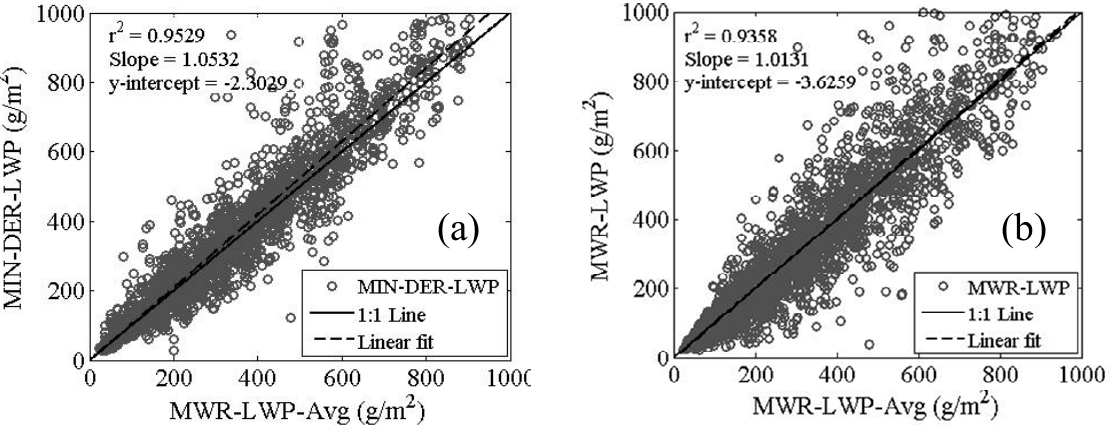
Figure 8. Regression plots between LWP derived in different ways ( a ) Closure comparison between averaged measured and derived LWP, and ( b ) Averaged versus Instantaneous